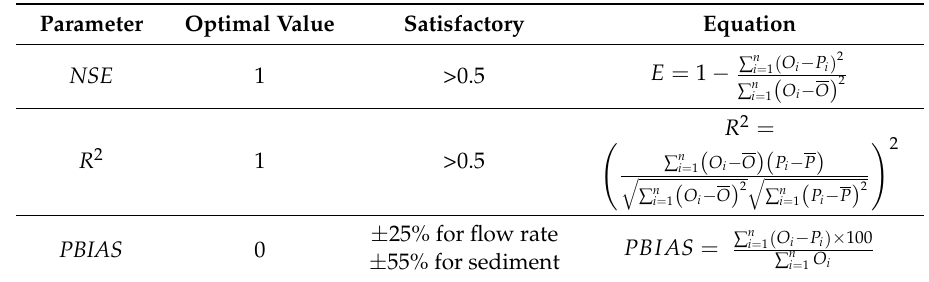
Table 5. Definition of error parameters and their accepted ranges for calibration. NSE —Nash–Sutcliffe efficiency; PBIAS —percent bias.